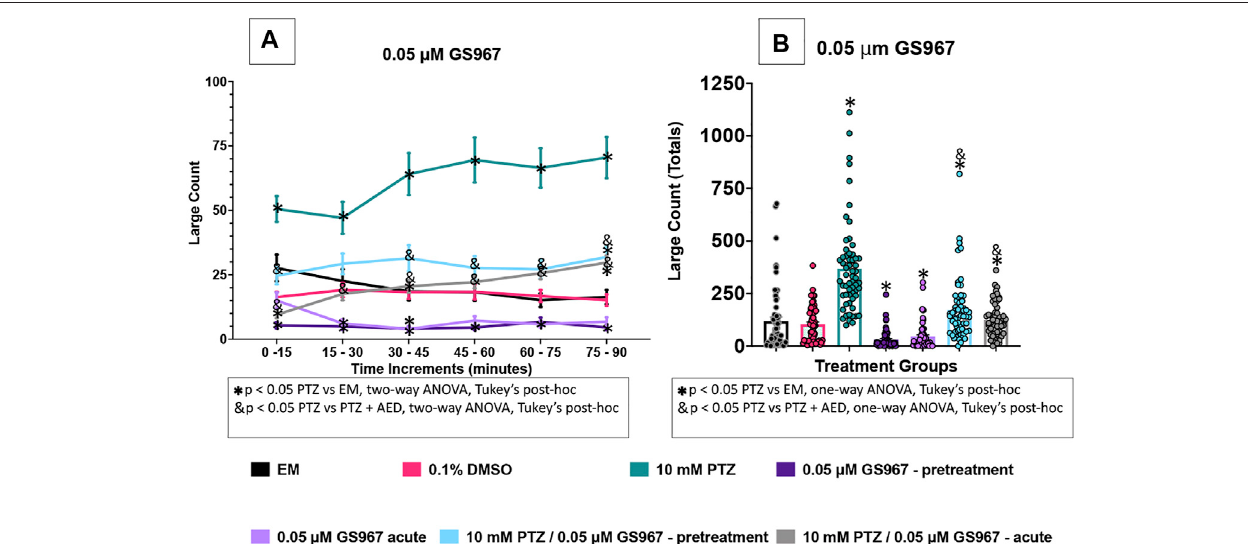
FIGURE 5 | Behavioral pro fi le of zebra fi sh larvae exposed to GS967. (A) The average large count ( y -axis) of larvae. The average larval large count is depicted per 15 mininterval( x -axis)ofthetrackingsession.Therespectivetreatmentgroups( x -axis).Analyses(two-wayANOVA,Tukey ’ spost-hoc)aremarked*( p < 0.05)toindicate signi fi cantdifferencestoembryomedium(EM).Standarderrorofthemeansisshown.Analyses(two-wayANOVA,Tukey ’ spost-hoc)aremarked&( p < 0.05)toindicate signi fi cant differences to 10 mM PTZ. (B) The total large count ( y -axis) over 90 min is displayed. The respective treatment groups ( x -axis). Analyses (one-way ANOVA,Tukey ’ spost-hoc) are marked *( p < 0.05) toindicate signi fi cantdifferences toembryomedium(EM). Standard errorofthe means isshown.Analyses(one-way ANOVA, Tukey ’ s post-hoc) are marked & ( p < 0.05) to indicate signi fi cant differences to 10 mM PTZ. ( n = 60 fi sh/treatment